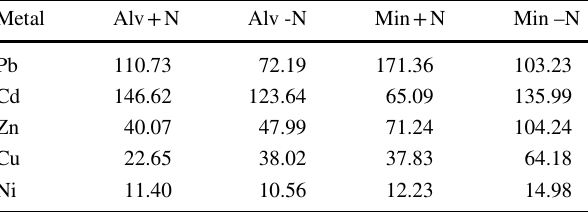
Table 5 Langmuir isotherm biosorption capacities of five metal ions (q max , mg/g) for the algae: Neochloris alveolaris + N ( Alv + N), Neo- chloris alveolaris -N ( Alv -N), Neochloris minuta + N ( Min + N), and Neochloris minuta -N ( Min